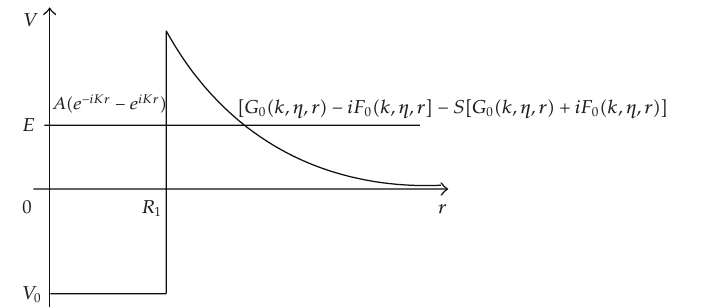
Figure 12: Schematic stationary description of a scattering in the presence of a coulomb barrier (cid:2) l (cid:6) 0 (cid:3)